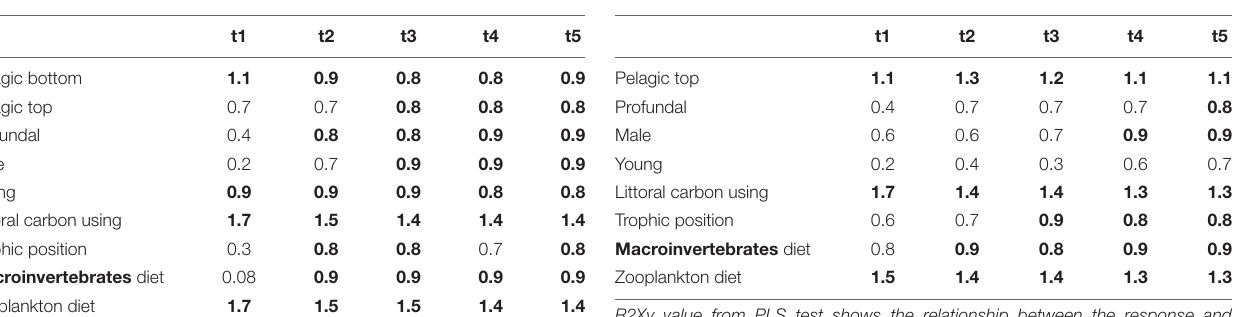
TABLE 5 | Results from PLS model 3 tested relationship between environmental and dispersal factors in perch.